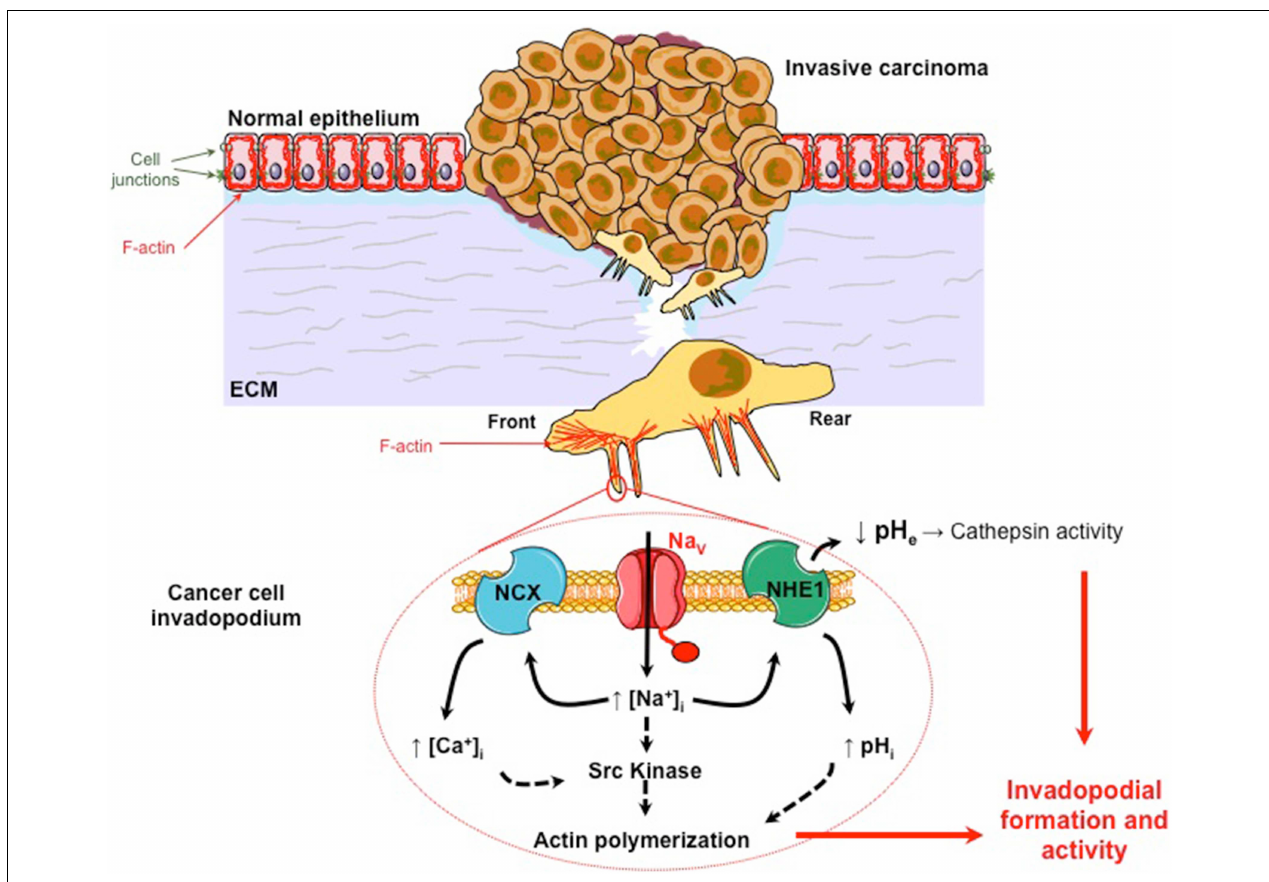
apico-basal polarization and now display a front-rear polarization. The proteolysis of the ECM by cancer cells is dependent on the formation and activity of protrusive structures, enriched in F-actin, called invadopodia. All these changes in cell phenotype and behavior are obtained through the process called Epithelial-to-Mesenchymal Transition (EMT). Na V α proteins are abnormally expressed in highly invasive